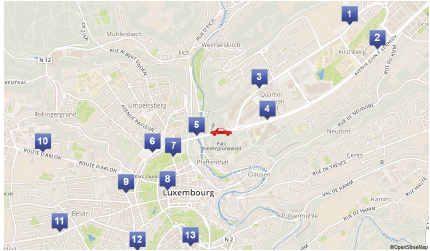
Figure 2: Luxembourg road network and traffic count positions. There are totally 13 traffic counts located over main road sections around Luxembourg City and the quarter of European Union Institutions (Kirchberg). The red car is the accident scenario occurring on Grand Duchess Charlotte Bridge standing in way for the direction to east during a.m. 7:30 to a.m.